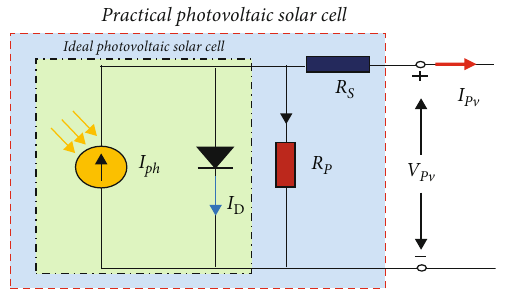
Figure 2: Photovoltaic solar cell equivalent